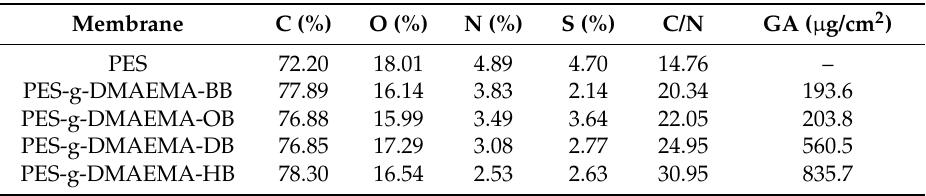
Figure 3. High-resolution XPS of membranes: ( a ) C 1s region of original PES; ( b ) C 1s region of PES-g-DMEAMA-HB; ( c ) N 1s region of original PE S; and ( d ) N 1s region of PES-g-DMEAMA-HB. Table 1. Element composition obtained by XPS and the grafting amount of the original and modified PES